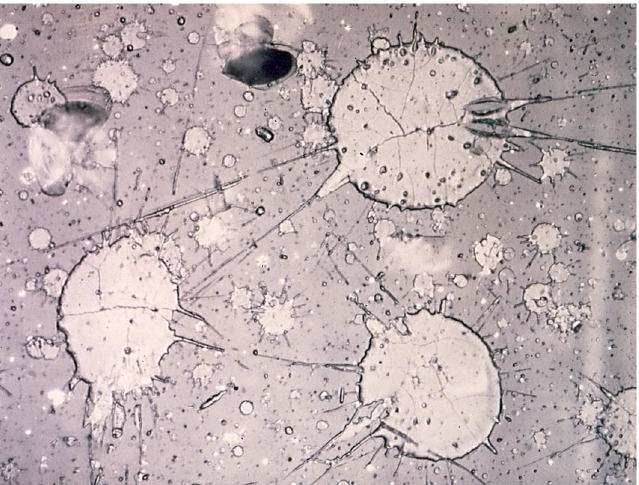
Figure 3. Frozen-in-time traces of atmospheric plasma-sprayed alumina particles, showing ejection of matter assisted by the action of planar shock waves. The flow pattern and spreading are the result of a ‘wipe test’. © With permission by Wiley-VCH, Weinheim,